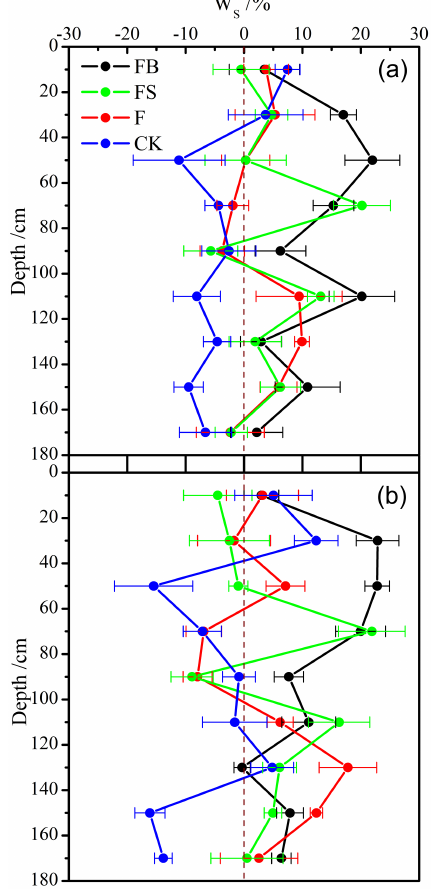
Figure 4. Relationship between compensation degree of soil water storage deficit ( W S ) and soil depth at 2013 (a) and 2014 (b) under fish-scale pits with branch mulching (FB), fish-scale pits with straw mulching (FS), fish-scale pits without mulching (F), and bare land treatment